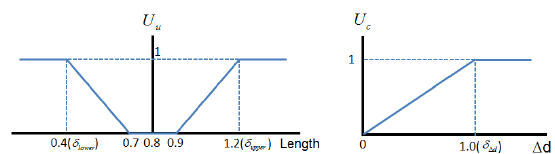
Figure 4. Functions used for scoring in door detection.